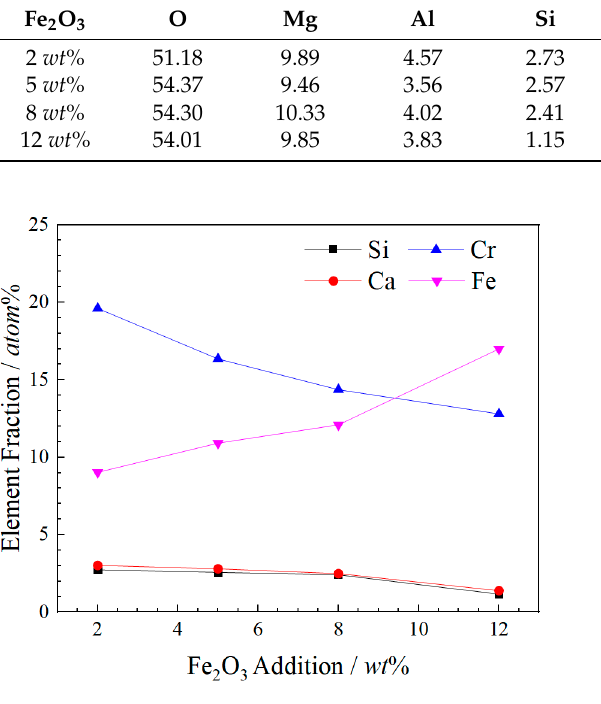
Figure 6. Variation of spinel crystals’ chemical compositions.